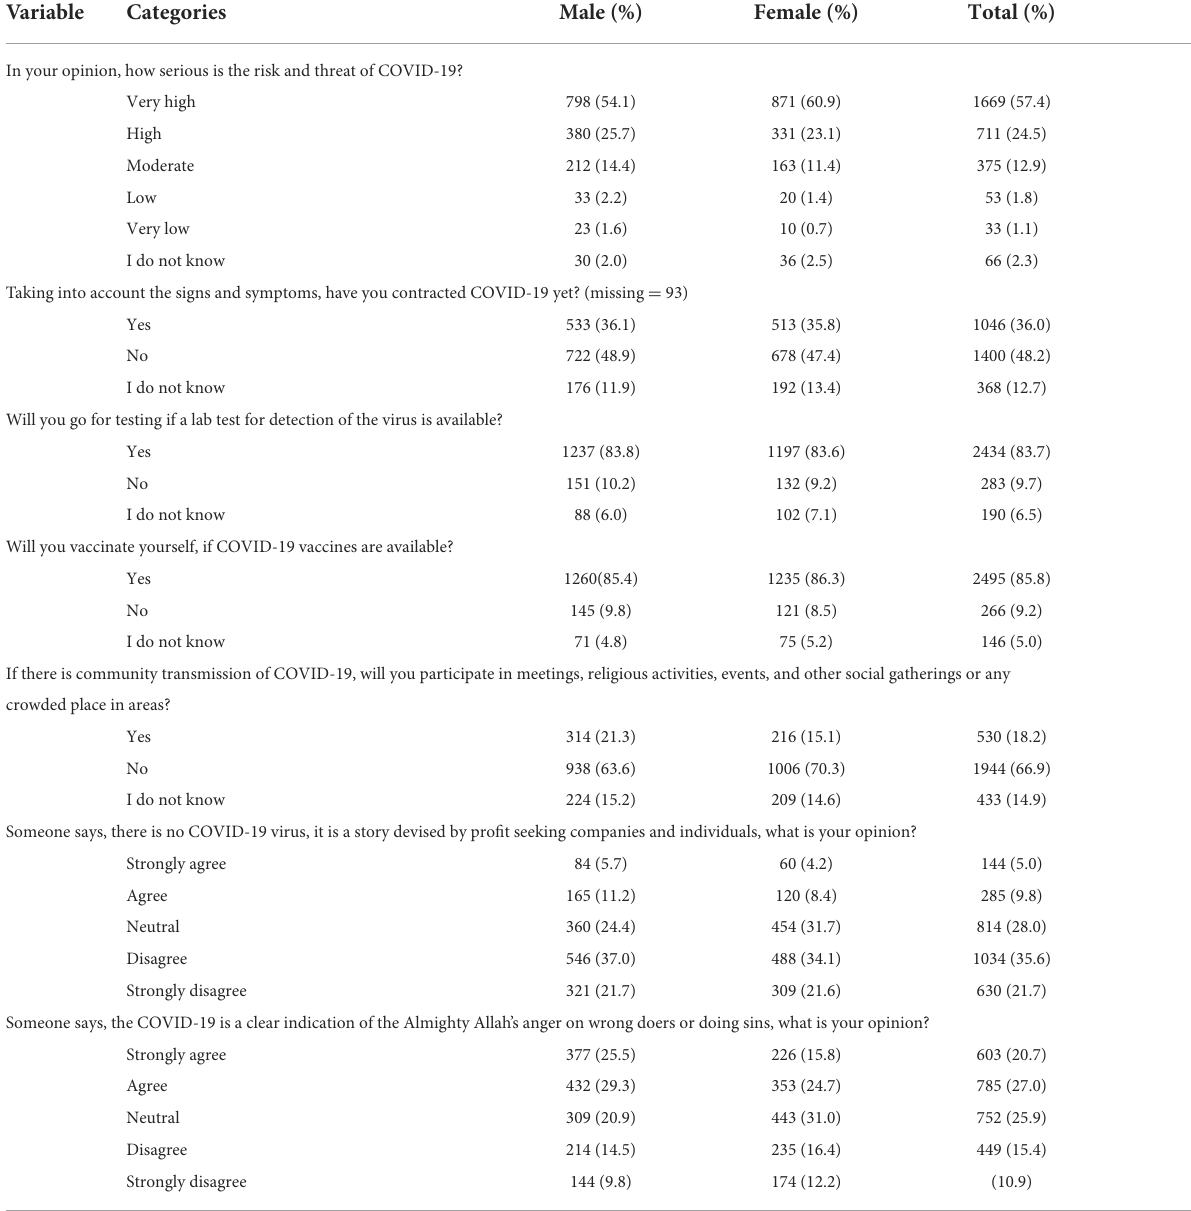
TABLE 4 Frequency distribution on attitudes of participants toward COVID-19 disease ( N =